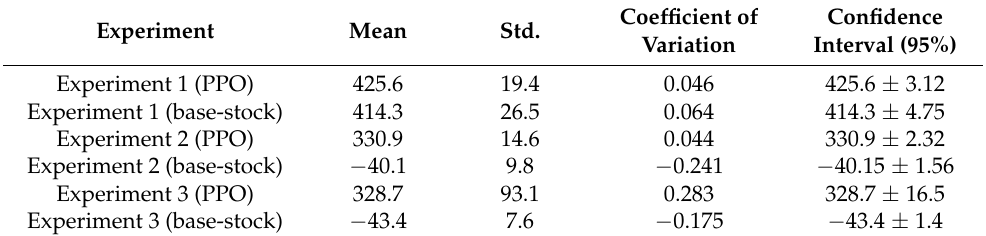
Table 5. Summary